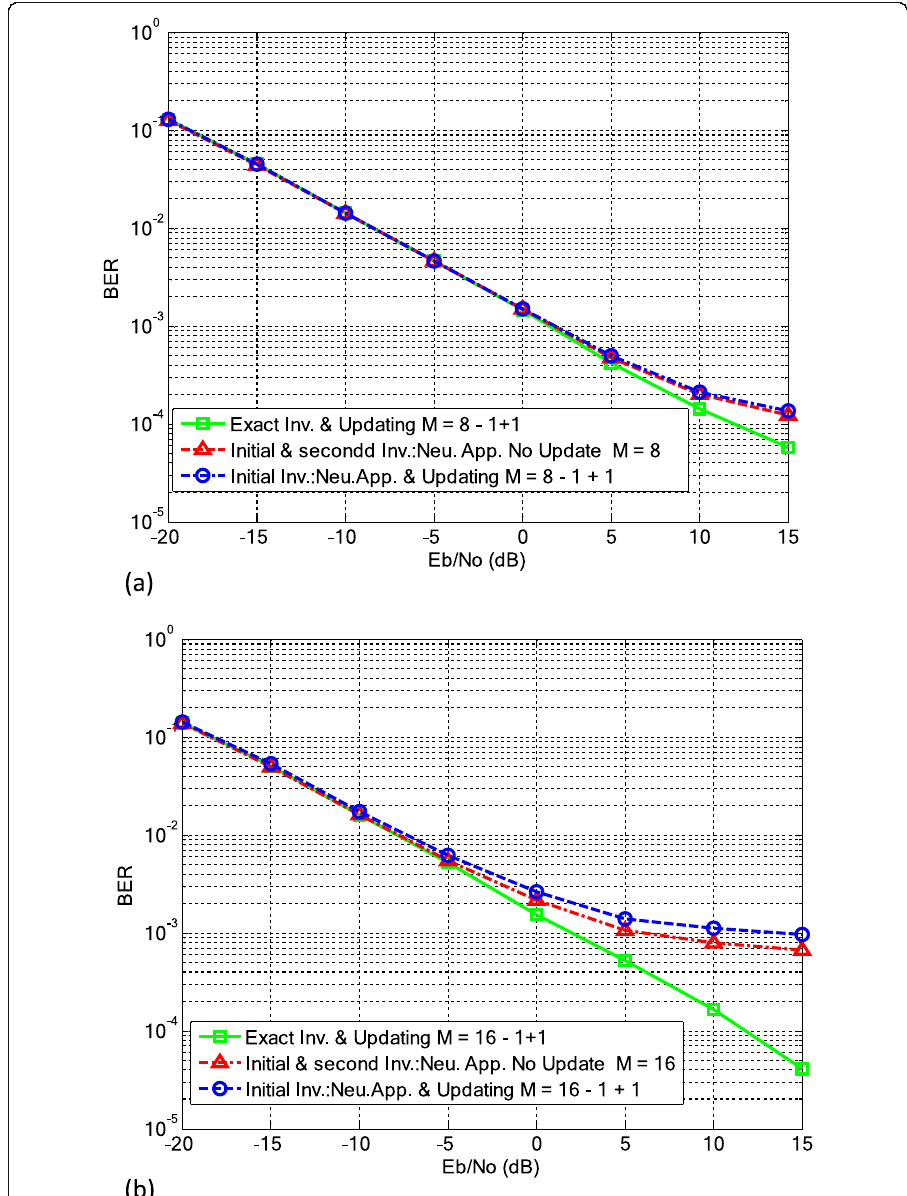
Fig. 5 BER performance comparison for updating the CSI of 1 user for the number of users M = 8 , 16.BS is equipped with N = 320 antennas that serves M = 8, 16 users. This simulation studies the case in which the channel estimation in changed for a particular user while the total number of users remains constant. Simulations ( a ) and ( b ) corresponds to the BER performance of the system with 8 and 16 users,